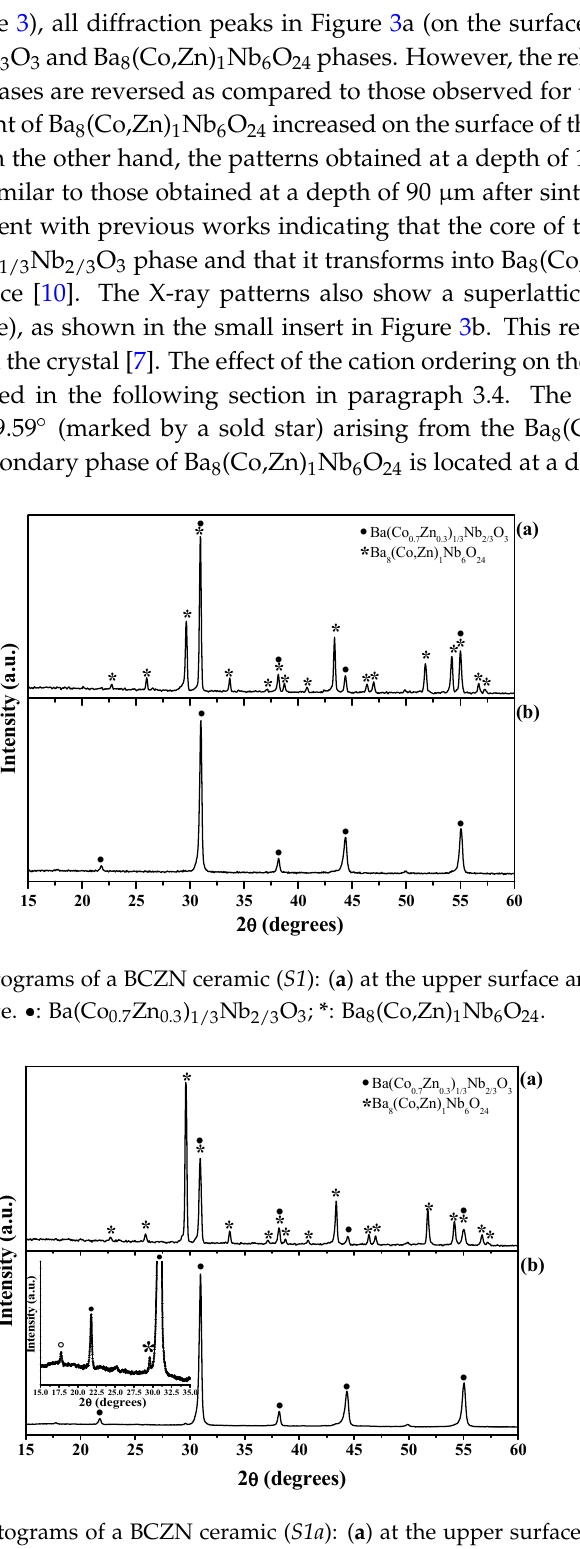
Figure 3. X-ray diffractograms of a BCZN ceramic ( S1a ): ( a ) at the upper surface and ( b ) at a depth of 120 µm below the surface. •: Ba(Co 0.7 Zn 0.3 ) 1/3 Nb 2/3 O 3 ; * : Ba 8 (Co,Zn) 1 Nb 6 O 24 . Inset: The region limited between 15° and 35° 2 θ shows a superlattice peak for 1:2 ordering which is denoted by an open circle.